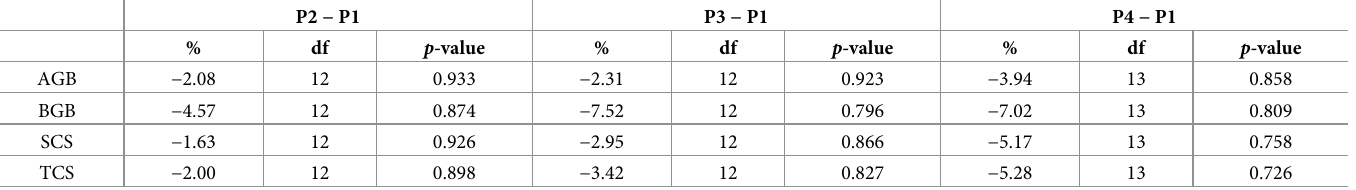
Table 8. Percentage changes in carbon reservoir means for the periods 1997–2003 (P2), 2004–2010 (P3), and 2011–2018 (P4) compared with the period 1990–1996 (P1) in Western Bahia. P2 − P1 P3 −